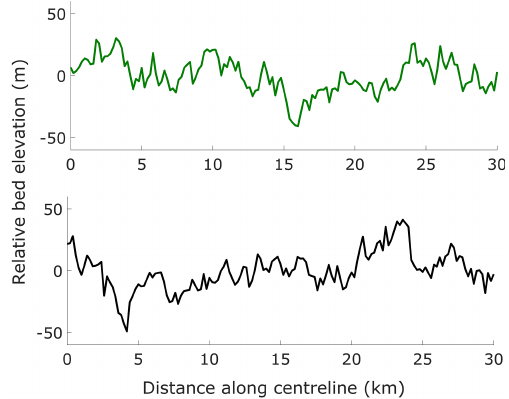
Figure 14. Two different realisations of the stochastic model for high-frequency perturbations to the synthetic fjord elevation pro- files. The model uses the parametric fit in Fig. 13 to generate the profiles and is statistically consistent with the OBS1516 bathy- metric profiles (green lines in Fig. 12). The overall trend of the fjord bathymetry and lower-frequency oscillations (corresponding to wavelengths 14km or greater) is not synthetically generated and explains why the amplitude of the modelled elevation is signifi- cantly less than the bathymetric observations in Fig.